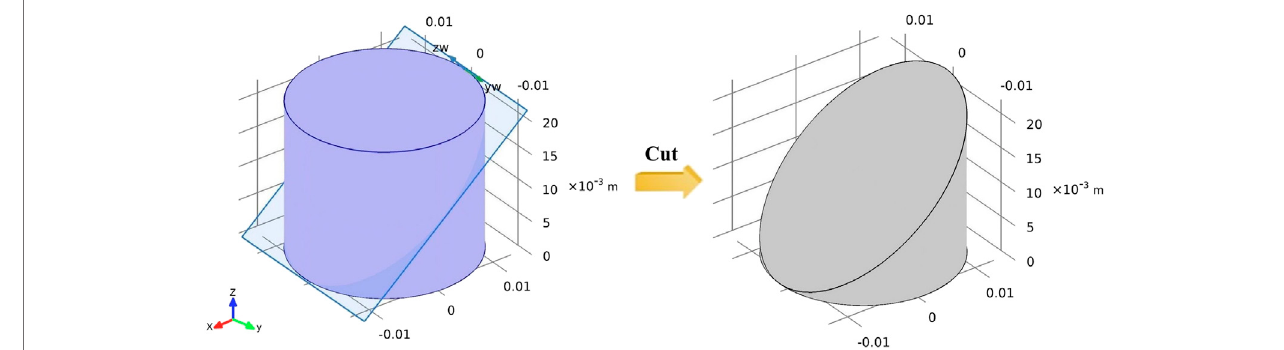
FIGURE 6 | Schematic diagram of sharp incision in inclined pipe.